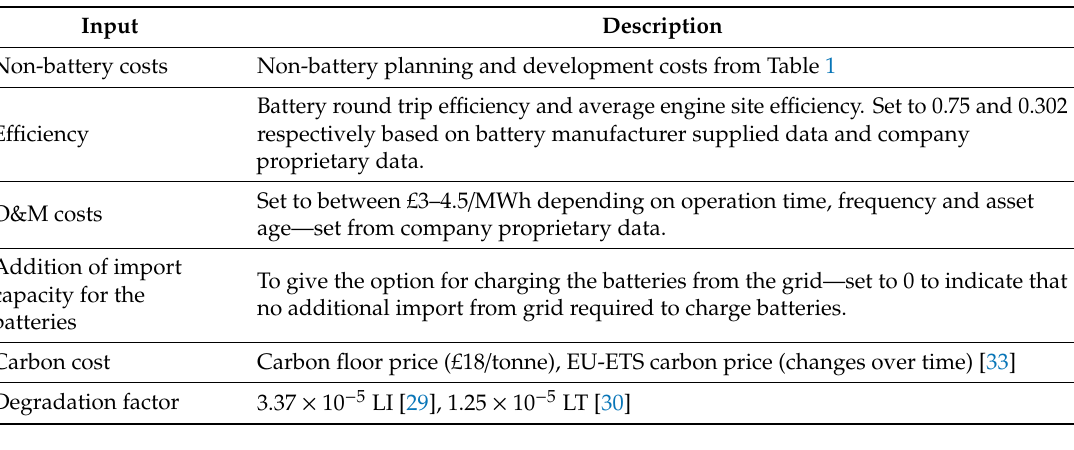
Table 8. Fixed data inputs to the model.